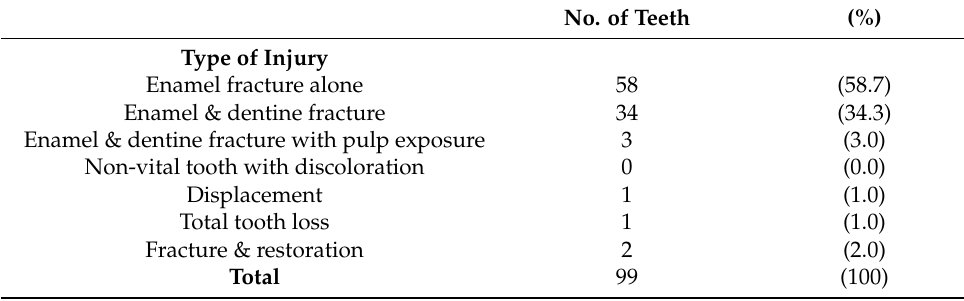
Table 4. Distribution of traumatized teeth according to the type of